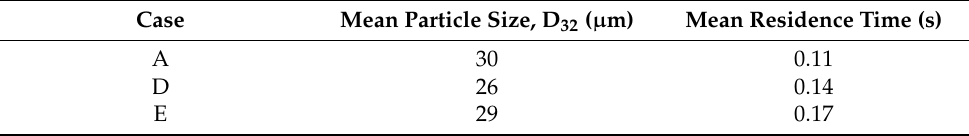
Table 5. Particle mean diameter and mean residence time at outlet.